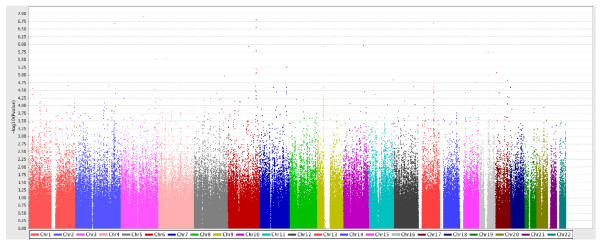
Manhattan plot for 555,525 genotyped single-nucleotide polymorphisms in 2,273 cases and 2,052 controls.